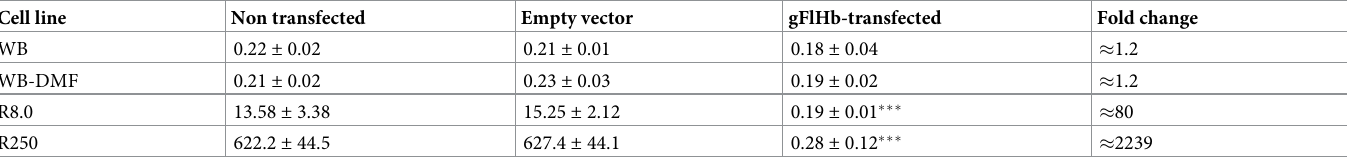
The IC 50 values are given in μ M. Values and errors (SE) shown are representative of n = 3 independent experiments. The asterisks indicate that values were different � p < 0.05 and ��� p < 0.001, as determined by ANOVA